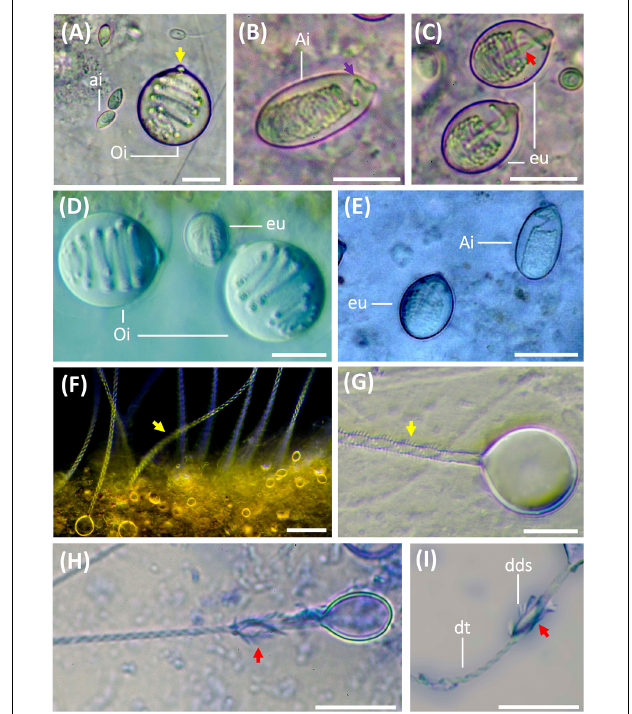
FIGURE 2 | Nematocysts during the life cycle of Pelagia noctiluca . Images from adult medusa, stage 6. (A–E) Undischarged nematocysts. (F–I) Discharged nematocysts. (A) O-isorhiza (Oi) with protruding apical capsular tip (yellow arrow) and loosely coiled tubule. Note small a-isorhizas (ai). (B,E ) A-isorhiza (Ai) with a closely packed tubule, only becoming more loosely coiled apically (violet arrow). (C) Eurytele (eu) with visible inverted shaft (red arrow). (D) . O-isorhizas (Oi) and euryteles (eu). (F,G) Discharged O-isorhizas with homotrichous spines in three helical spine-rows (yellow arrows) along the tubule. (H,I) Discharged euryteles with distal dilatations of shafts (dds) armed with heterotrichous spines (red arrows) and helical spine pattern on distal tubule (dt). Note proximal, spineless, narrow shaft in (I) . ai, a-isorhiza; Ai, A-isorhiza; dt , distal tubule; dds , distal dilatation of shaft; Oi, O-isorhiza; eu , eurytele. Scale bars: 10 µ m, scale bar F: 40 µ m. (A–D,F–I) photographed by Rubén